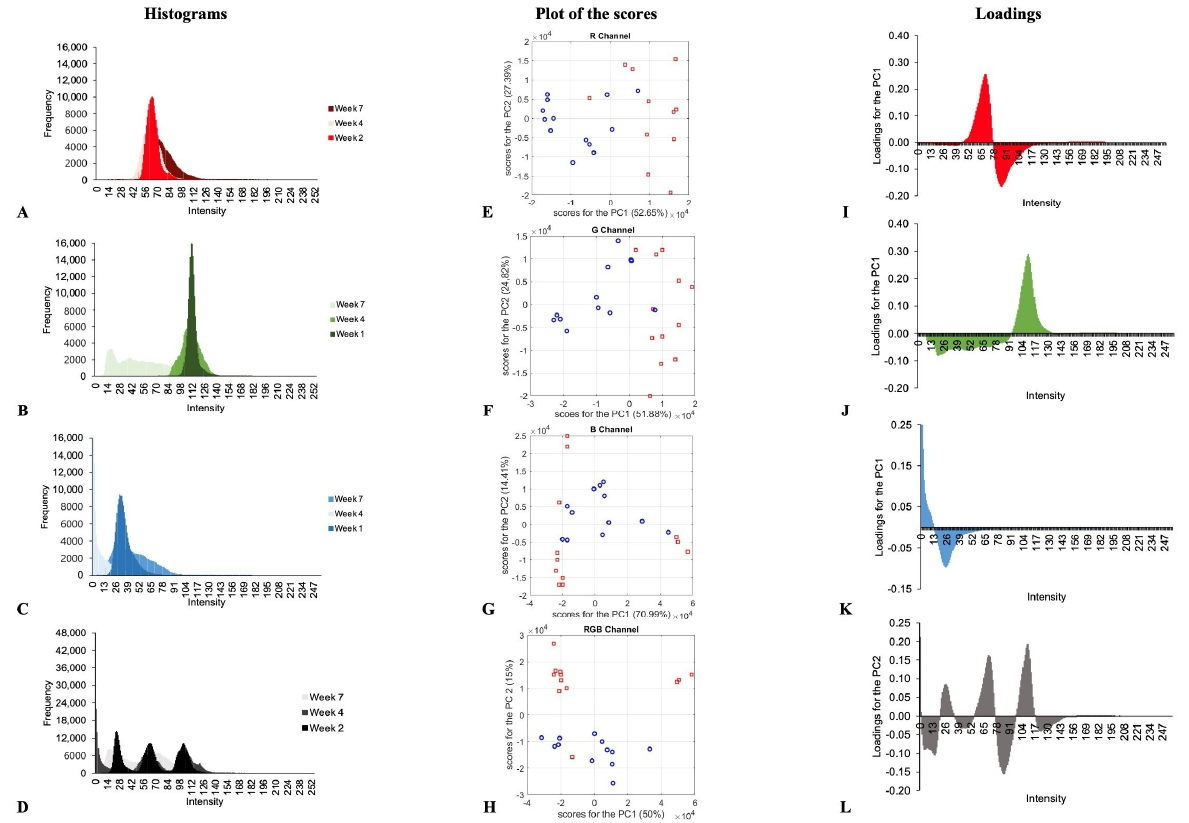
Figure 3. Histograms ( A – D ), scores values of the two first PCA components ( E – H ) and loading profiles of the first PCA component ( I – L ) for the R, G, B and RGB channels along the maturation